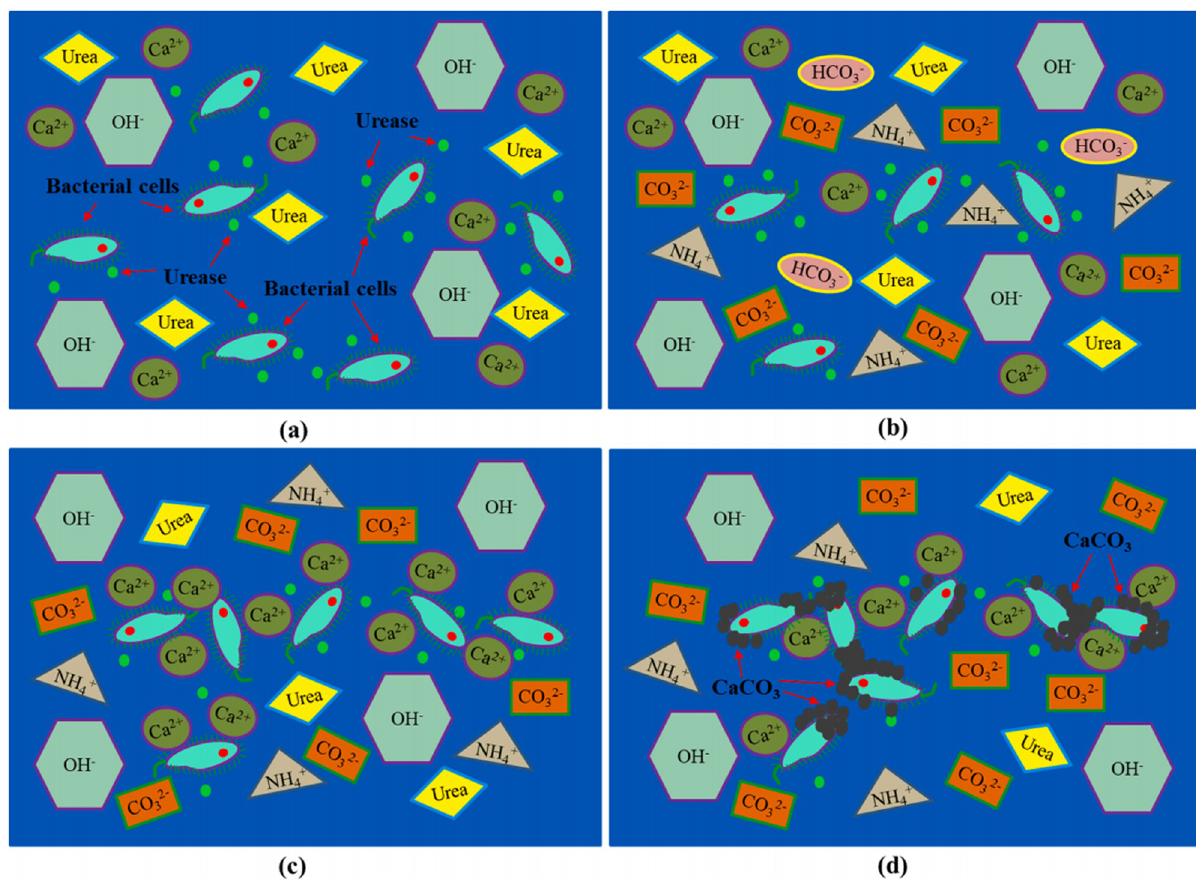
Fig 1. Mineralization mechanism of calcium carbonate precipitation induced by microorganism in solution. (a): Bacterial growth and urease production; (b): conversion and formation of various inorganic ions; (c): Ca 2 + adsorption by bacterial cells; (d): Bacterial cells as nucleation sites and deposition of CaCO 3